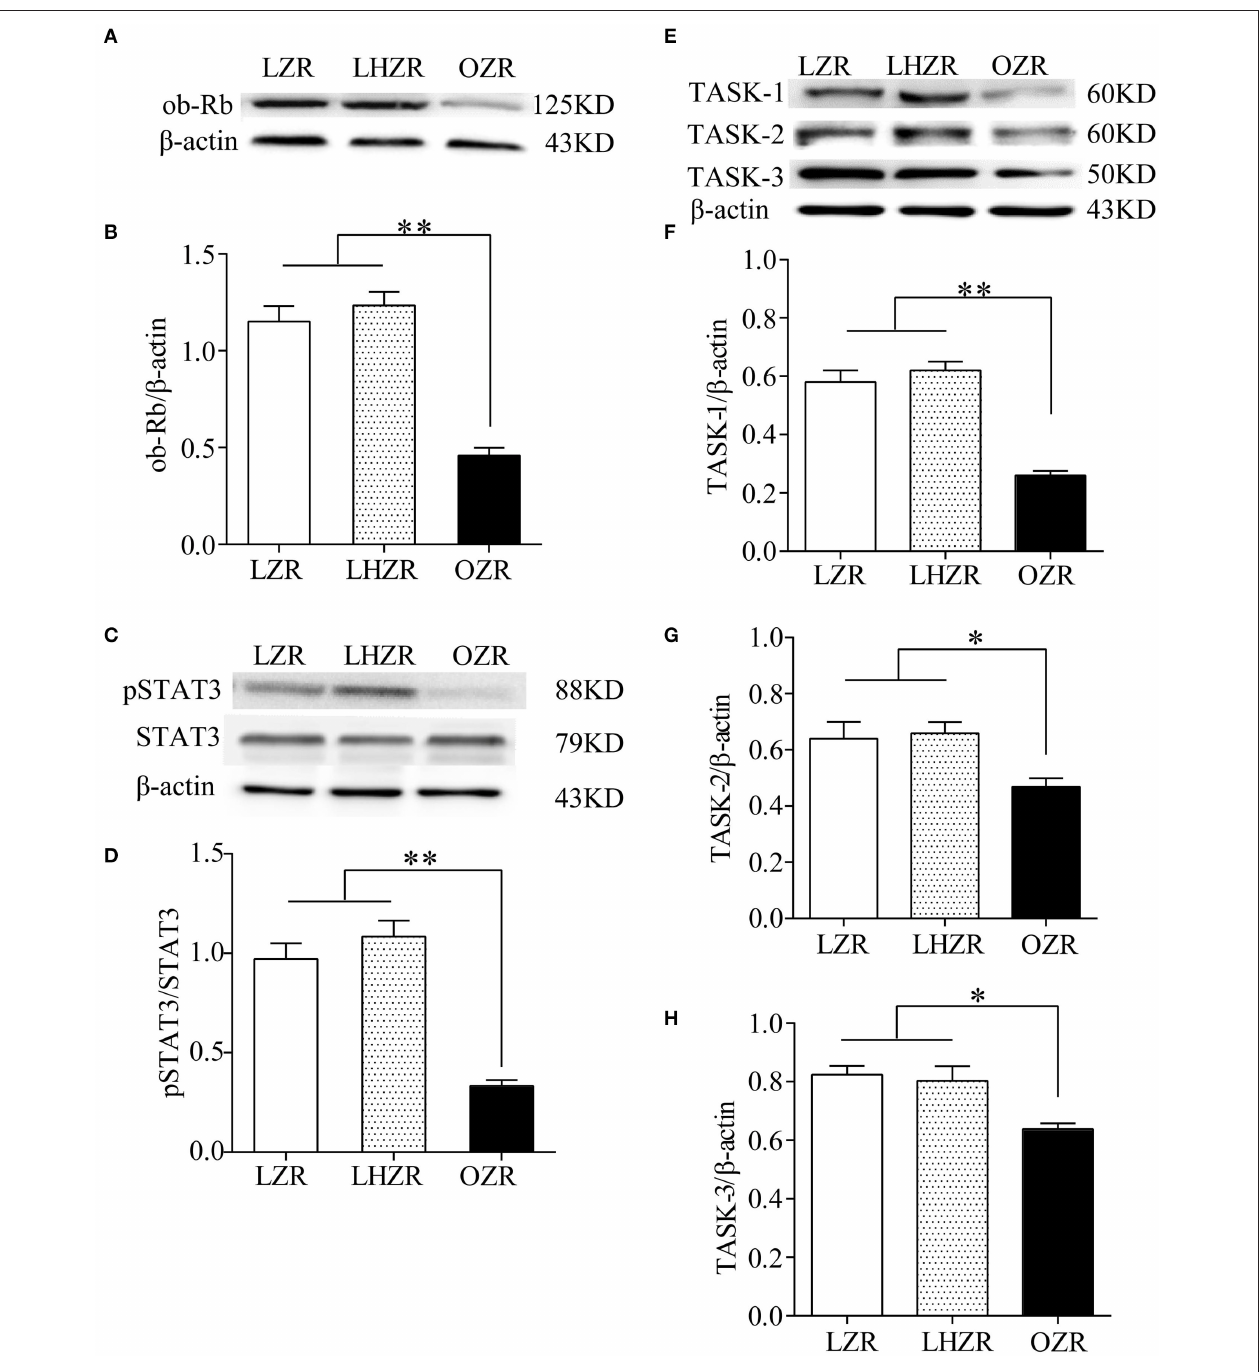
FIGURE 2 | Downregulation of pSTAT3/STAT3 and TASK-1,-2,-3 channels in CBs. Gel images and bar charts showing quantitative analysis of expression of ob-Rb (A,B) , pSTAT3/STAT3 (C,D) , and TASK-1,-2,-3 (E–H) in the CB ( n = 8) from each group ( n = 4). * P < 0.05, ** P < 0.01 by one-way ANOVA with Dunnett’s post-hoc test. ob-Rb, leptin receptor type b; STAT3, signal transducers and activators of transcription 3; pSTAT3, phosphorylated STAT3.